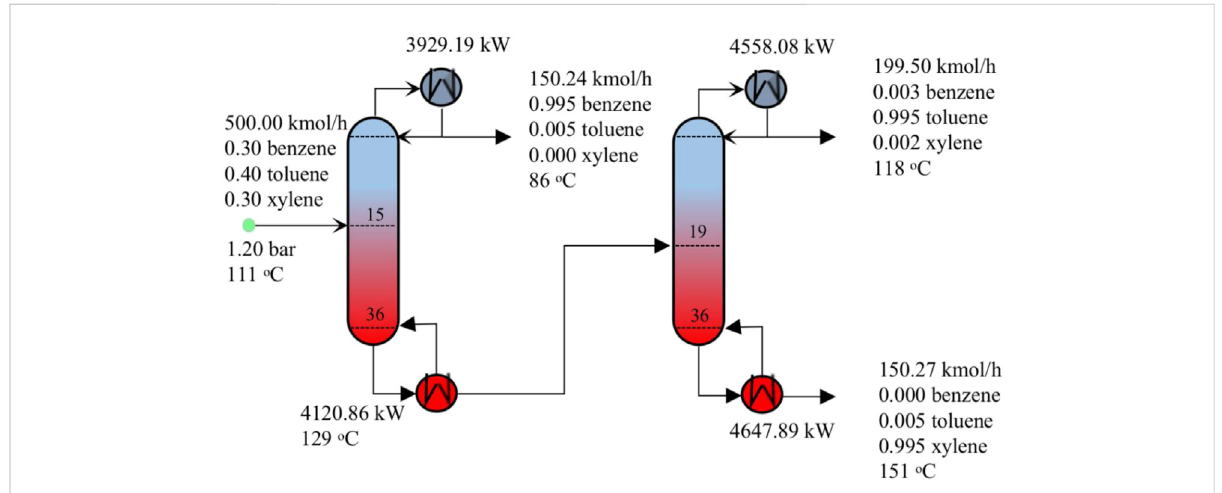
FIGURE 11 Optimal distillation sequence with operating conditions for Example